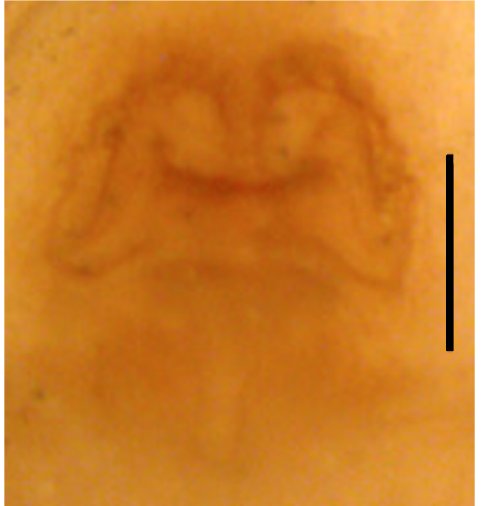
Fig. 16. Holotype of Pochyta remyi Berland & Millot, 1941, ♀, epigyne (photo T. szűts). scale bar: 0.2